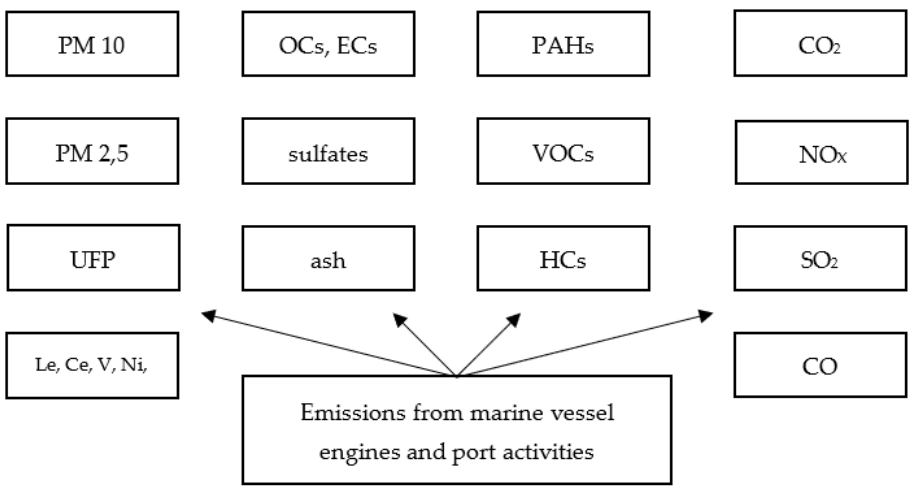
Figure 1. Compounds of emissions from marine vessel engines Sources: [26].